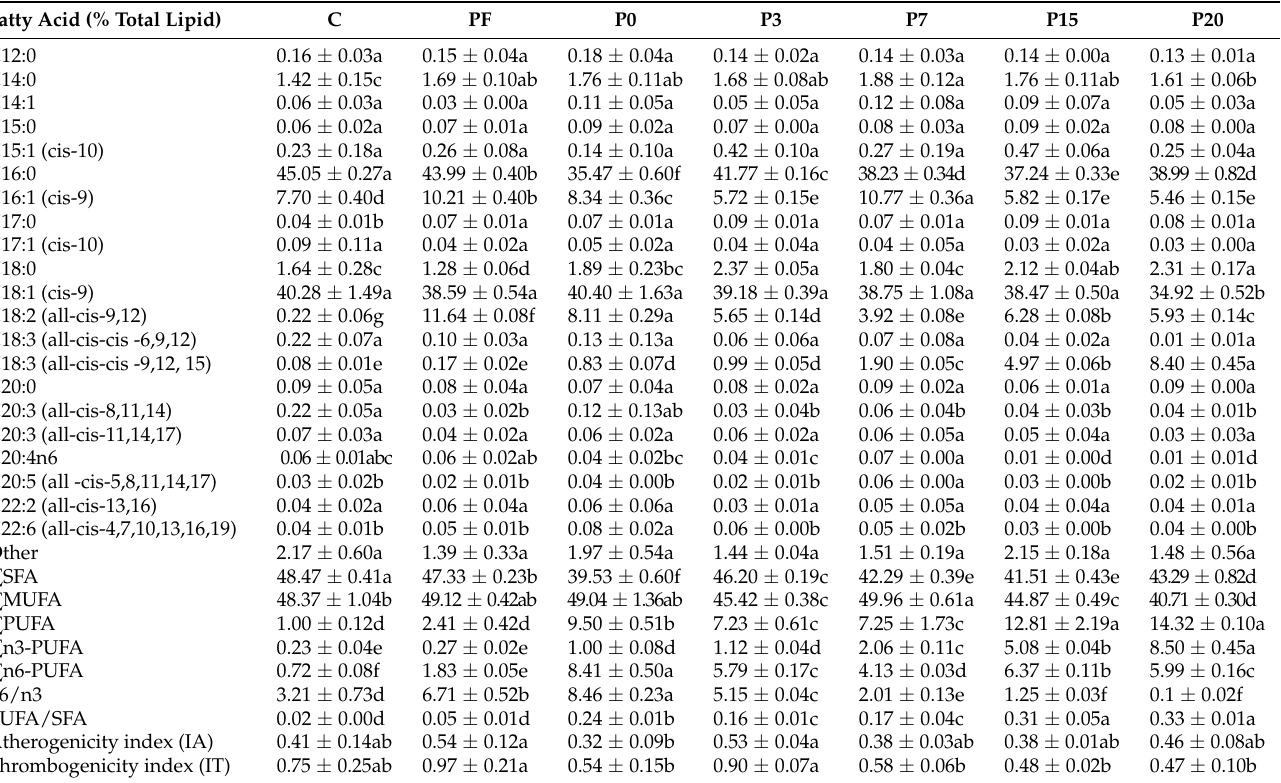
(Table 6), with SPWL raised on a PI-added diet having the lowest IA value and SPWL fed only PI or PI with PS having the lowest IT value ( p < 0.05). By significantly altering the FA composition of SPWL, it is possible to obtain healthier lipids for hypercholesterolemic or diabetic people by feeding SPWL with 7–20% PS-formulated diets. Table 6. Fatty acid composition of sago palm weevil larvae (SPWL) fed on different diets. Fatty Acid (% Total